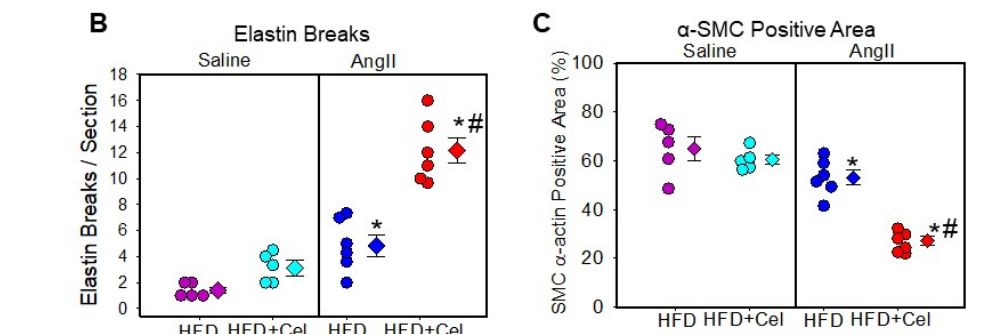
Figure 4. ( A ) Representative suprarenal aortic tissue sections from saline or Ang II (500 ng/kg/min)